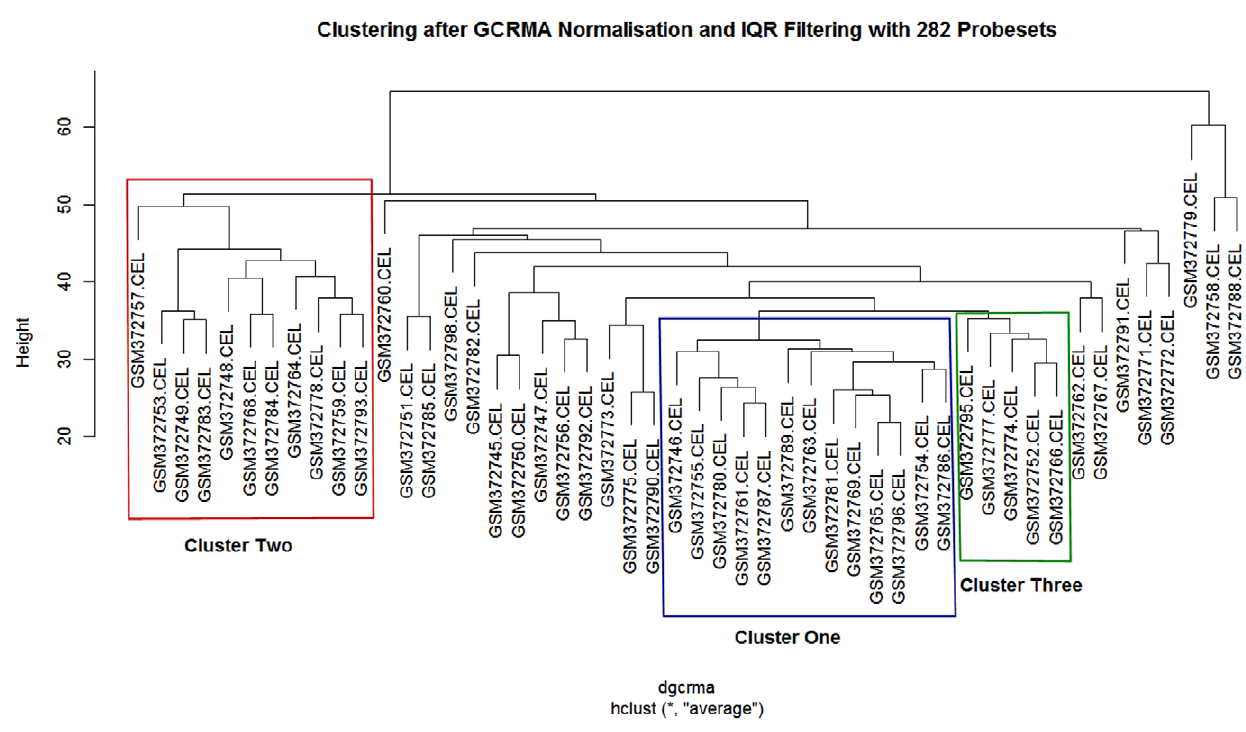
Figure 2. Cluster dendrogram from hierarchical agglomerative clustering of the gcrma normalised data, filtered with interquartile range filtering to give 282 probesets.